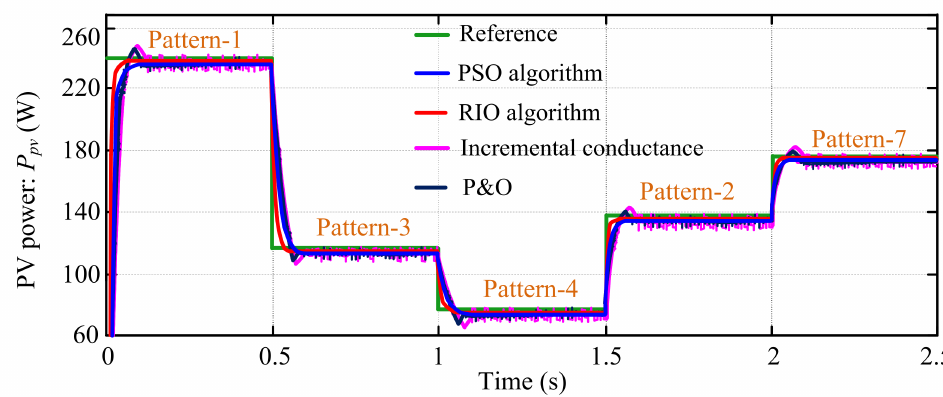
Figure 11. PV system output power performance graph.